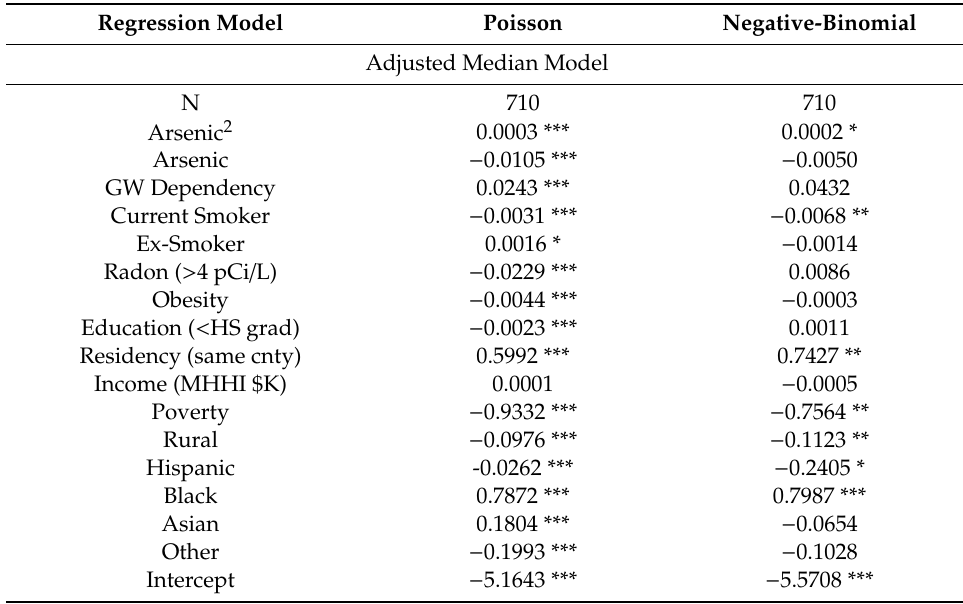
Table 4. Adjusted Poisson Regression and Negative-Binomial Regression Models of Median Arsenic Exposure and Prostate Cancer Incidence (Maximum < 200 µ g / L; Median < 100 µ g / L, and Dependency > 10%). Regression